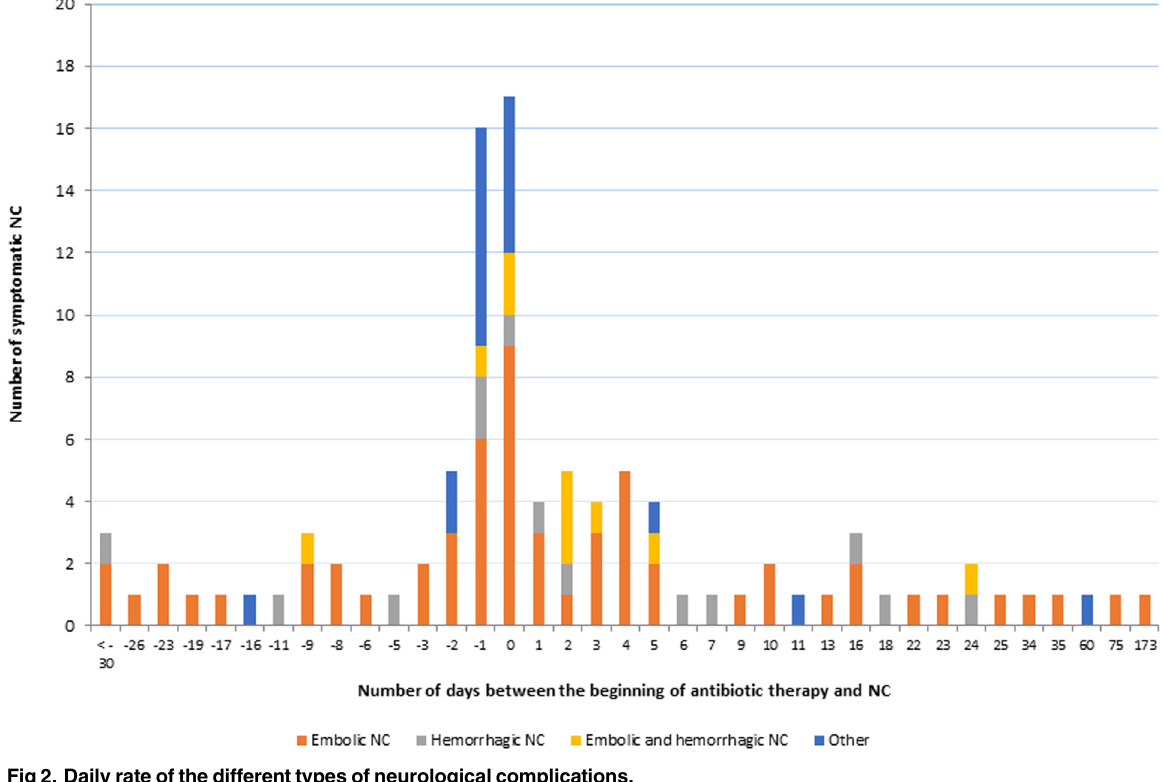
Fig 2. Daily rate of the different types of neurological